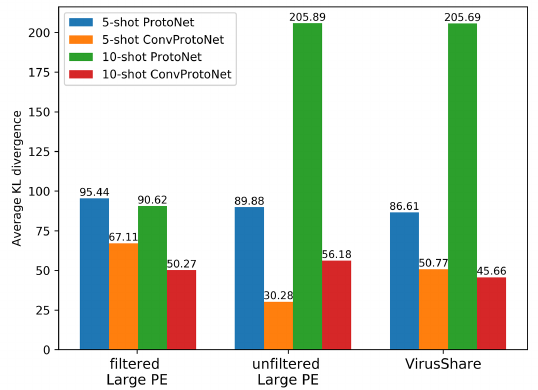
Figure 9. Average KL divergence between the fitted distribution generated by two models and distribution of embedded data. The distribution of prototypes from ConvProtoNet and ProtoNet are estimated by gaussian KDE on over 1000 sample points and the average KL divergence is computed for 100 epoches.